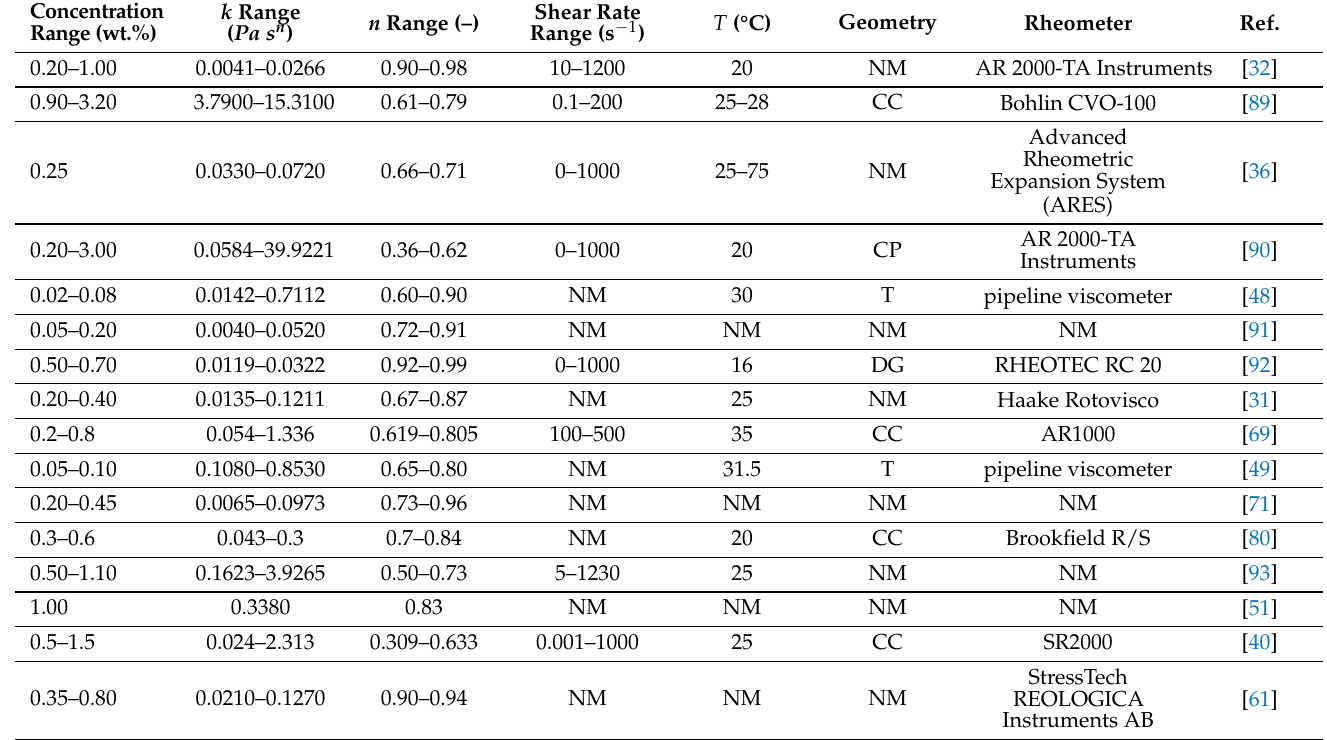
Table 4. Different rheological parameters for CMC available in the